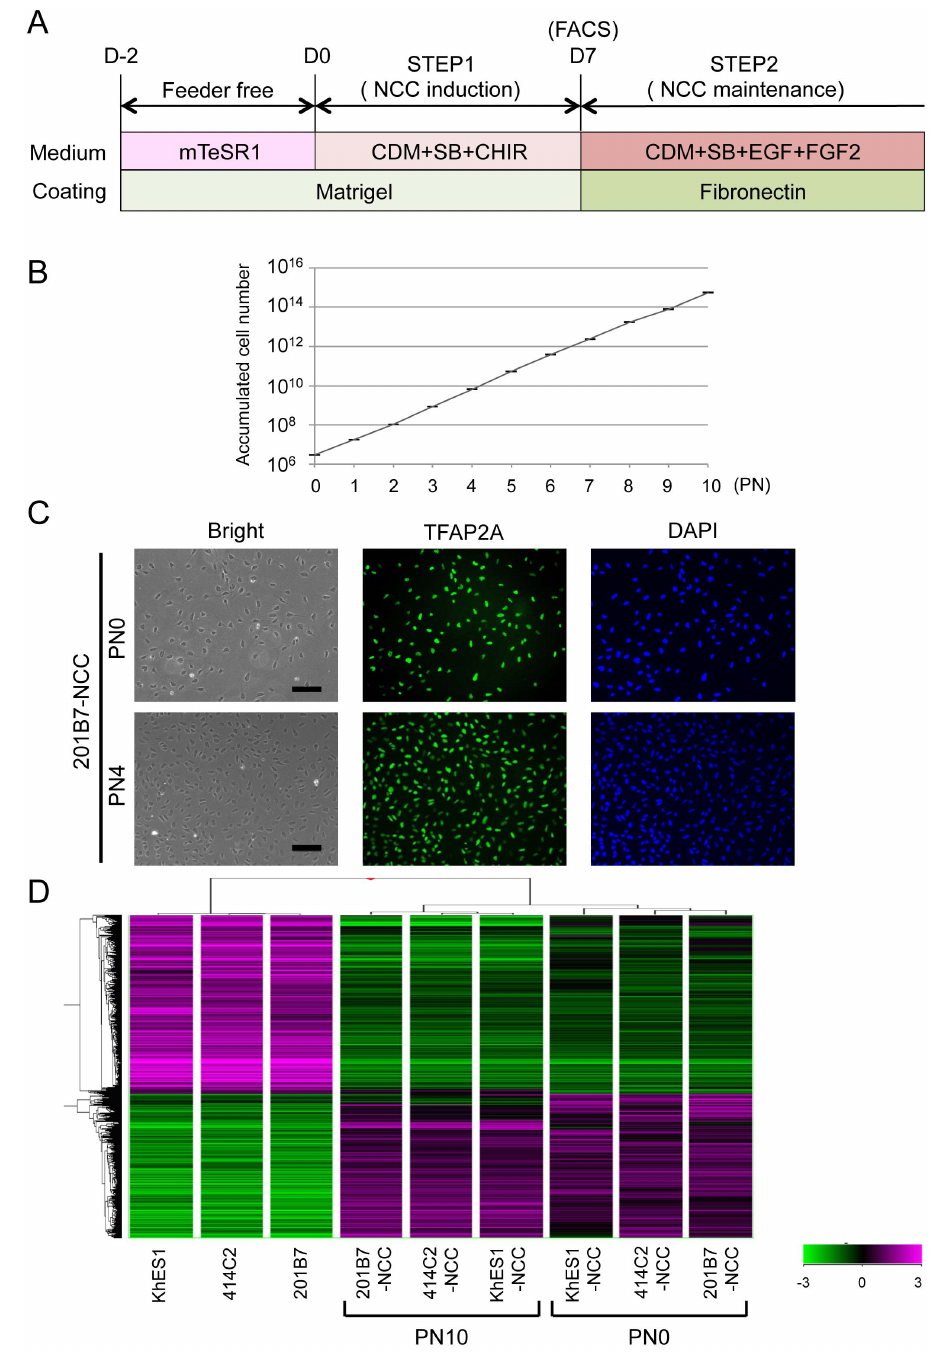
Figure 3. Sustained expansion of hNCCs with original characteristics. A) Schematic representation of the culture conditions. B) Growth profile of 201B7-derived hNCCs. Average ¡ SD. N 5 3, biological triplicate. C) Phase contrast images and immunostaining of TFAP2A in 201B7-derived hNCCs at PN0 and PN4, Scale bar, 200 m m. D) Hierarchical clustering analyses of hPSCs and hPSC-derived hNCCs at PN0 and